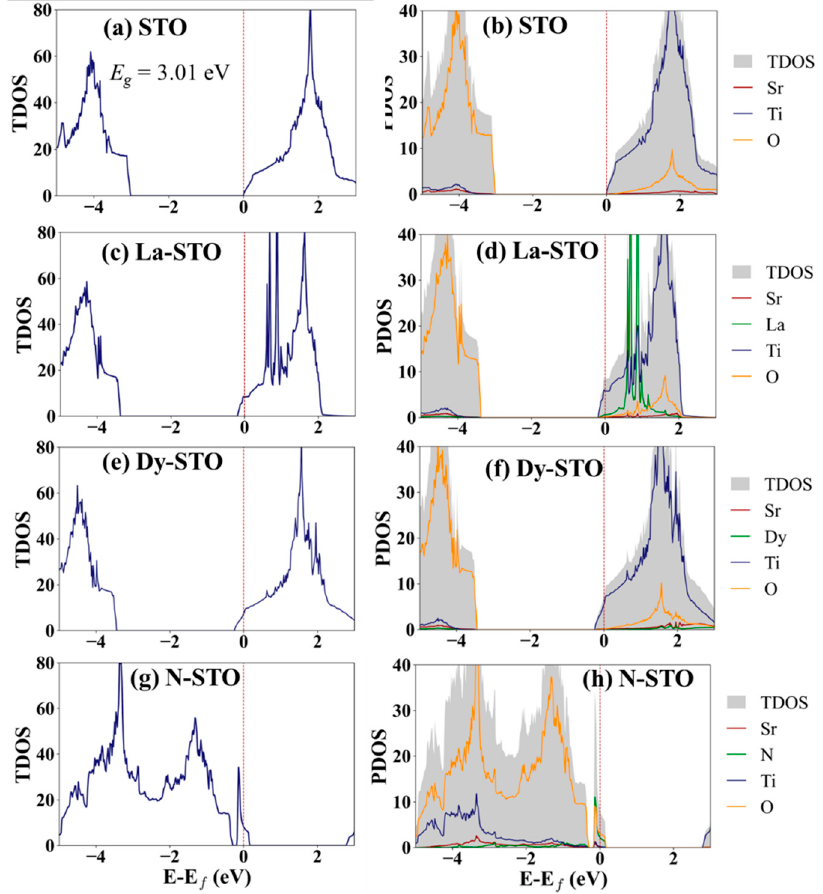
Figure 3. ( a , c , e , g ) Total and ( b , d , f , h ) partial DOS of ( a , b ) undoped SrTiO 3 and for mono-doping with: ( c , d ) La, ( e , f ) Dy, and ( g , h ) N. For co-doped systems, the total DOS of (La, Dy) and (La, N) co-doped SrTiO 3 struc- tures is shown in Figure 4. E f is shifted to a higher level compared to the STO. The E f is at 8.22 and 7.78 eV for (La, Dy) and (La, N) co-doping, respectively. Comparing the DOS of the co-doped systems to those of undoped SrTiO 3 , it can be seen that (La, N) co-doping can induce a new state in the forbidden band, like the N doping. For the DOS of (La, Dy)- co-doping, not much difference is observed compared to the La and Dy mono-doping. A clear difference in electronic structures is seen for both mono-doping and co-doping, which affects the carrier behavior and is expected to be able to improve the thermoelectric properties of the STO. Partial and projected DOS (PDOS) plots are shown in Figures S6–S15. The valence band maximum comes from the p electrons of Sr and O while the conduction band mini- mum results from the d orbitals of Ti for STO. After doping, a clear change in the DOS of valence orbitals for the host atoms is observed for N mono- and (La, N) co-doping. New states at the valence band maximum (VBM), called “stepping stones,” are observed for the systems with N doping. These stepping stones form from interaction of all elements in the systems. Moreover, interestingly, Ti states are at the bottom of the CBM for STO and (La, N)-co-doped STO, the same position as E f , while they are lower than the Fermi level for La-, Dy- and (La, Dy)-doped STO. (La, N)-doped STO is a neutrally doped mate- rial, similar to the undoped STO, because doped atoms create one hole and one free elec- tron. It therefore possesses similar Ti states, at the CMB, to STO.